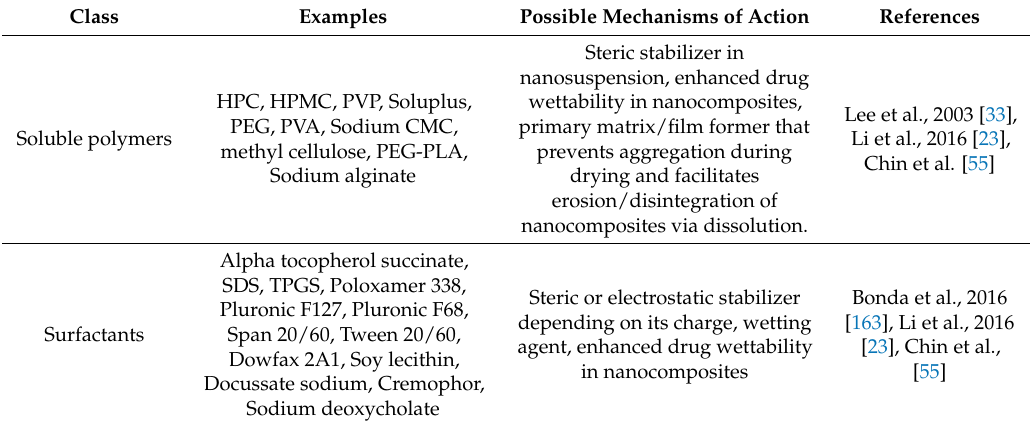
Table 3. Classification of dispersants used in drug-laden